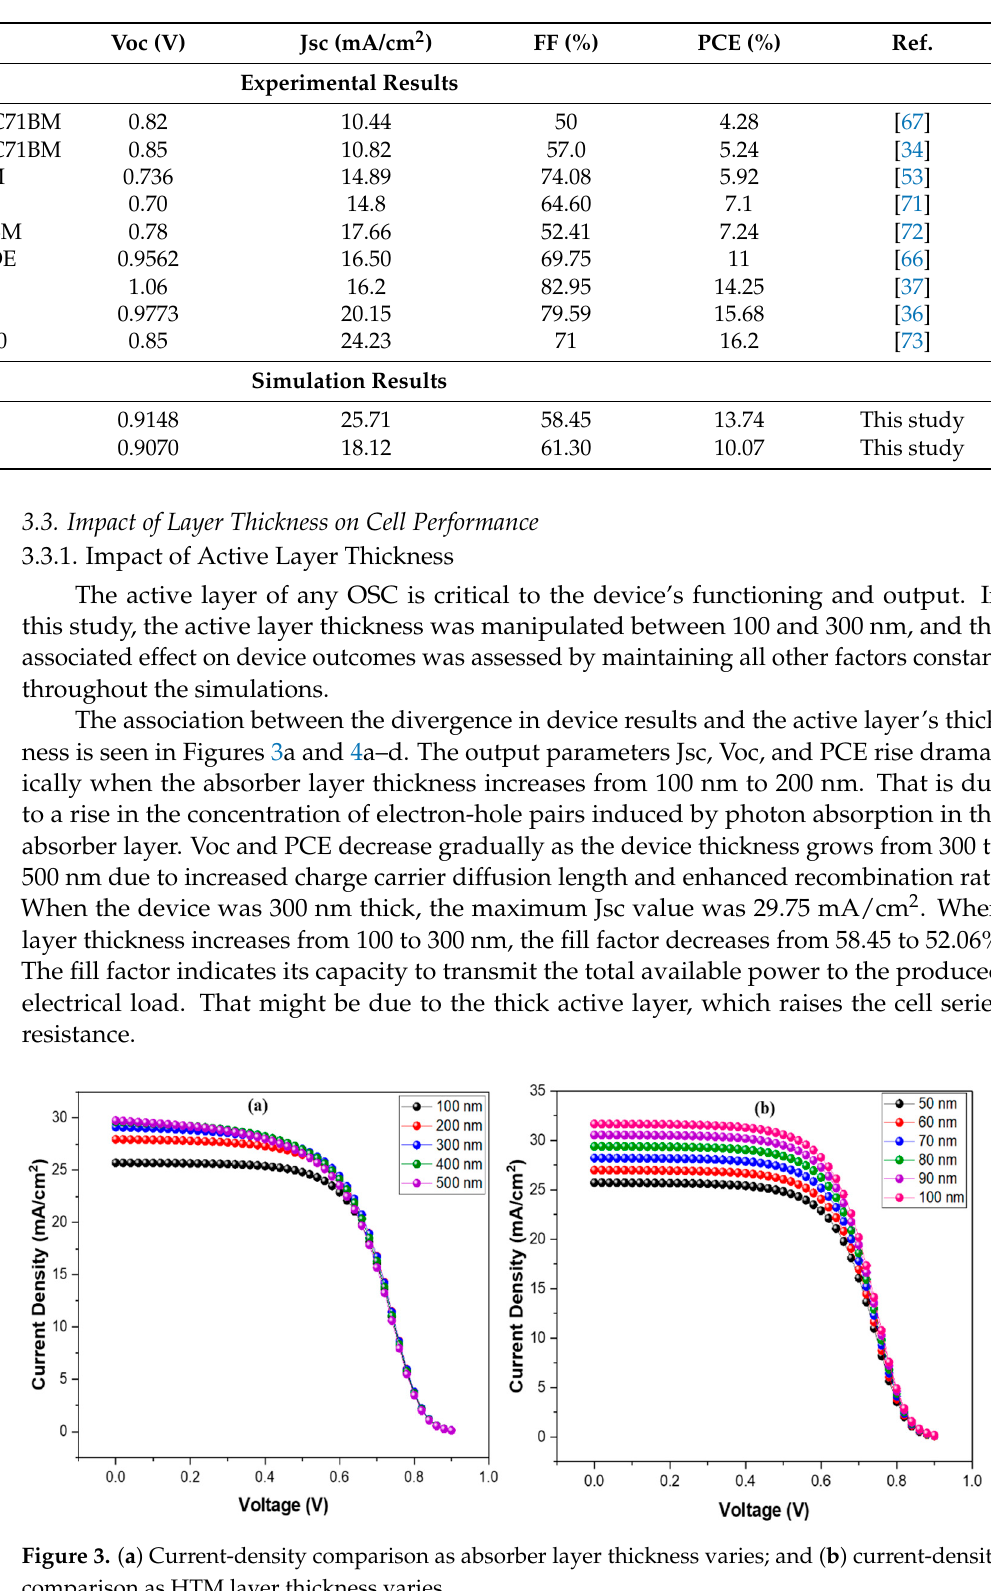
Table 4. A comparison of bulk heterojunction OSC theoretical and experimental data.